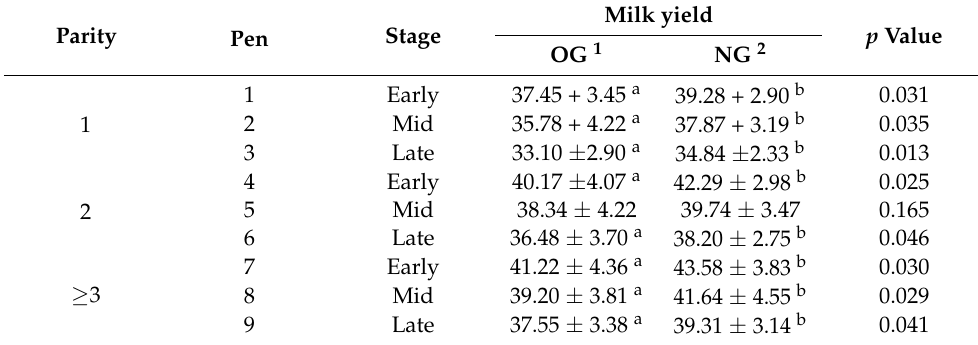
Table 5. Effects of farm group and nutrient group strategies on milk production of dairy cows.